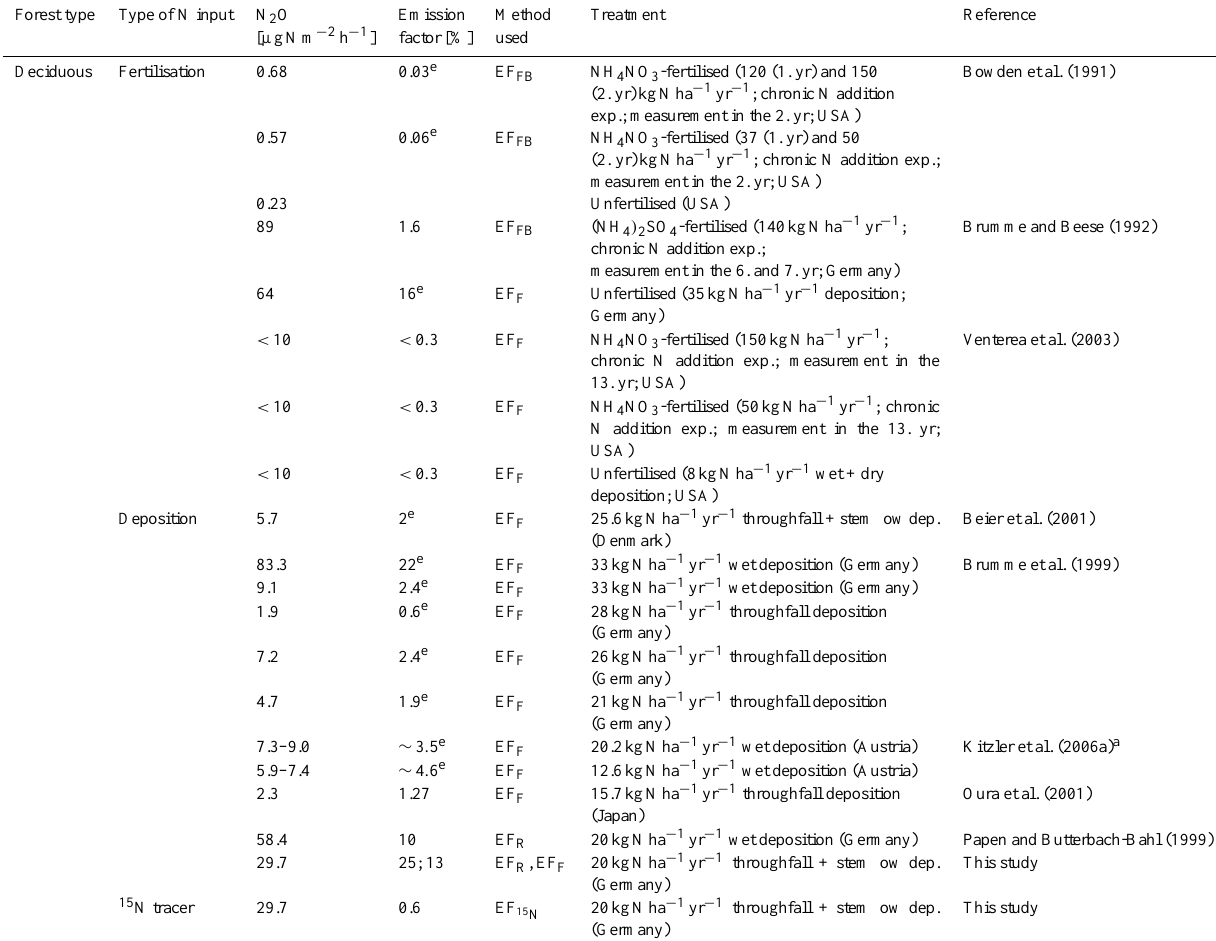
Table 5. Compilation of published studies that investigated the impact of N input on N 2 O fluxes from deciduous and coniferous temperate forest soils. Studies are divided into fertilisation, deposition, and 15 N tracer experiments. The emission factor (EF) for N 2 O is given for one year if not differently indicated.